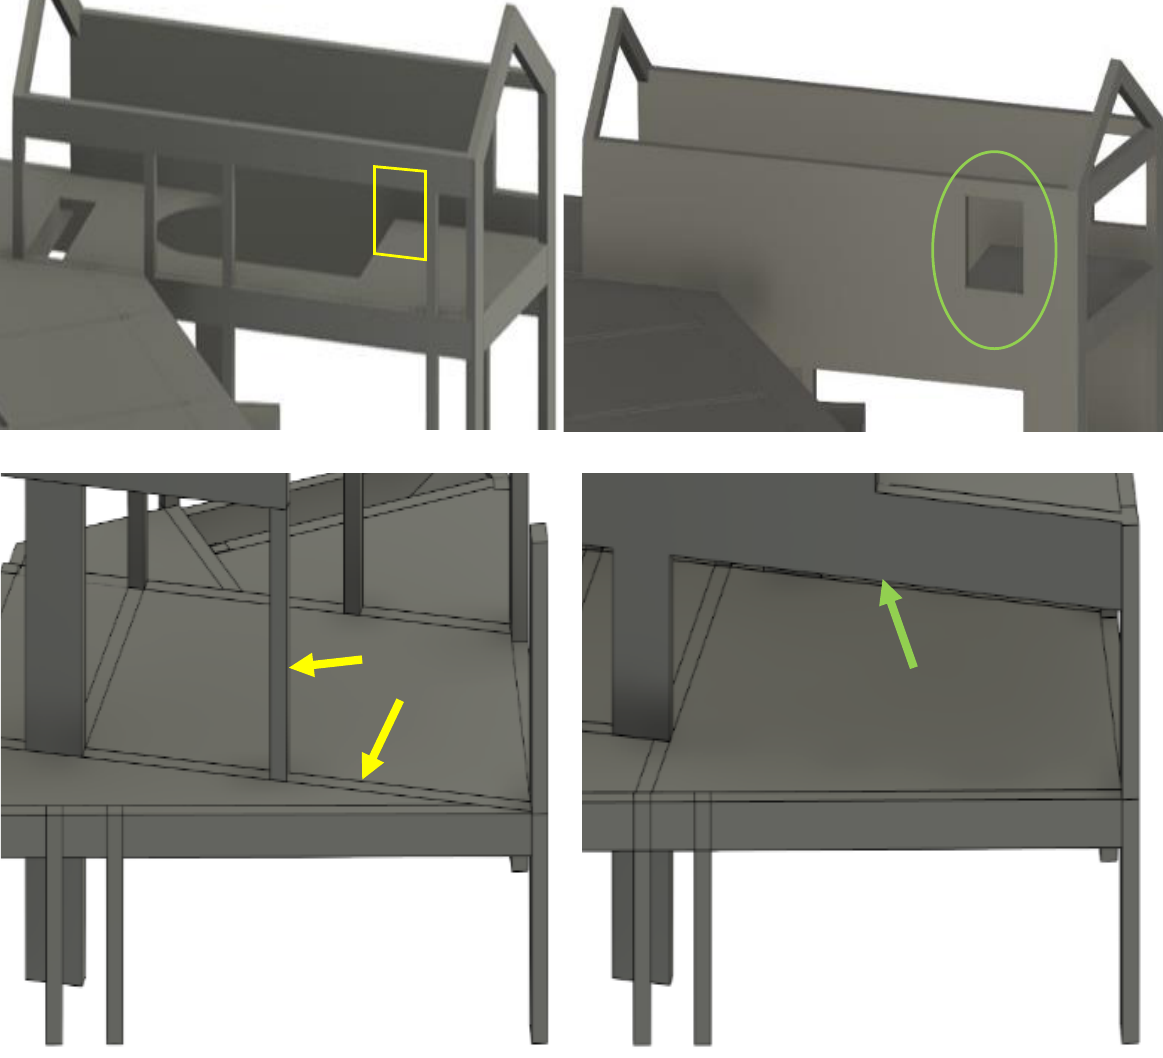
Figure 3. The structural solution before and after the amendments.